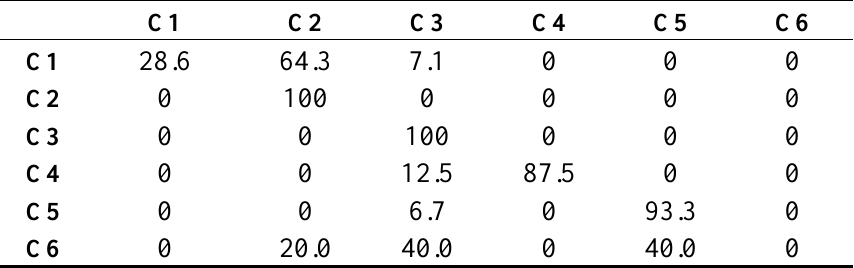
Table 7. Confusion matrix for the context recognition with motion features (Unit: %).